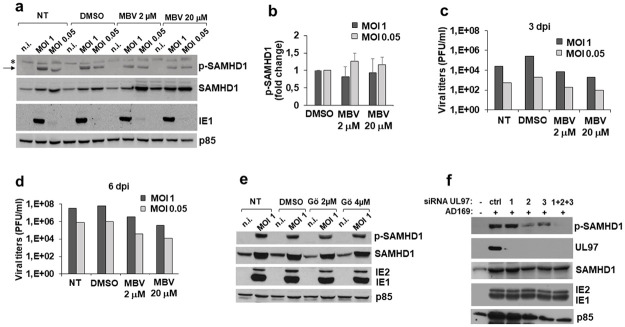
Effects of HCMV kinase pUL97 inhibition on SAMHD1 phosphorylation at T592.a) HFFs were not infected (n.i.) or infected with AD169 at the indicated MOI, in the presence of different concentrations of the pUL97 inhibitor Maribavir (MBV). After removing virus inoculum, MBV was newly added and kept until cell harvesting at 1 dpi. Total or pT592-SAMHD1 levels, expression of IE1/IE2 viral antigens and of p85 were analyzed by immunoblotting as above. A representative experiment out of two performed at 8 hpi, 1, 3 and 6 dpi is shown. b) The relative amount of pT592-SAMHD1 normalized to that of p85 was determined by densitometric analysis and is relative to that of DMSO-treated cells, which was arbitrarily set as 1. Data are expressed as mean ± SE of two independent experiments (MOI 1, 1 dpi). The analysis revealed no statistically significant difference. c-d) Effect of MBV on infectious virus production as measured by standard plaque assays on cell culture supernatants at 3 dpi (c) or 6 dpi) (d). Results derive from one representative experiment out of two. e) Total or pT592-SAMHD1 was analyzed as in panel a) in cells treated with the inhibitor Gö6976 (Gö). A representative experiment out of two performed at 3 dpi is shown. f) HFFs were transfected with three different UL97 siRNAs, alone (1, 2, 3) or in combination (1+2+3), or with a non-targeting siRNA (ctrl). The day after, cells were infected with AD169 at an MOI of 1 and harvested at 3 dpi. Immunoblotting was performed as above. One representative experiment out of two is shown. NT, not treated cells; DMSO, cells treated with the vehicle DMSO; *, unspecific band; black arrow, pT592-SAMHD1 specific band.